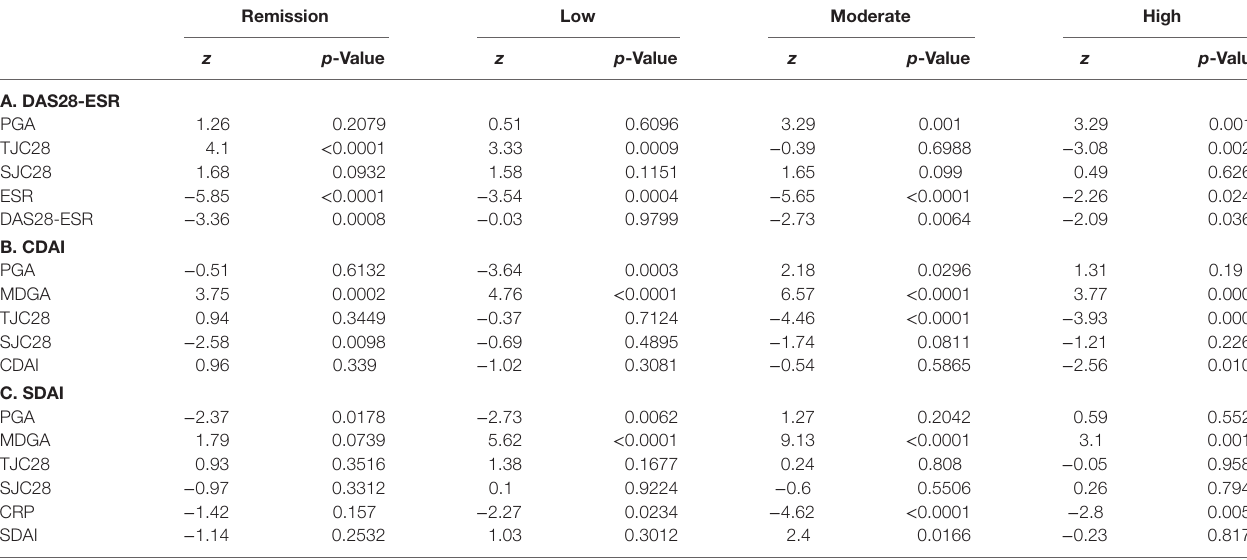
TaBle 7 | Comparison of the mean of the components of the disease activity indices within each disease activity state between Dutch and Portuguese populations using one randomly selected visit per patient. remission low